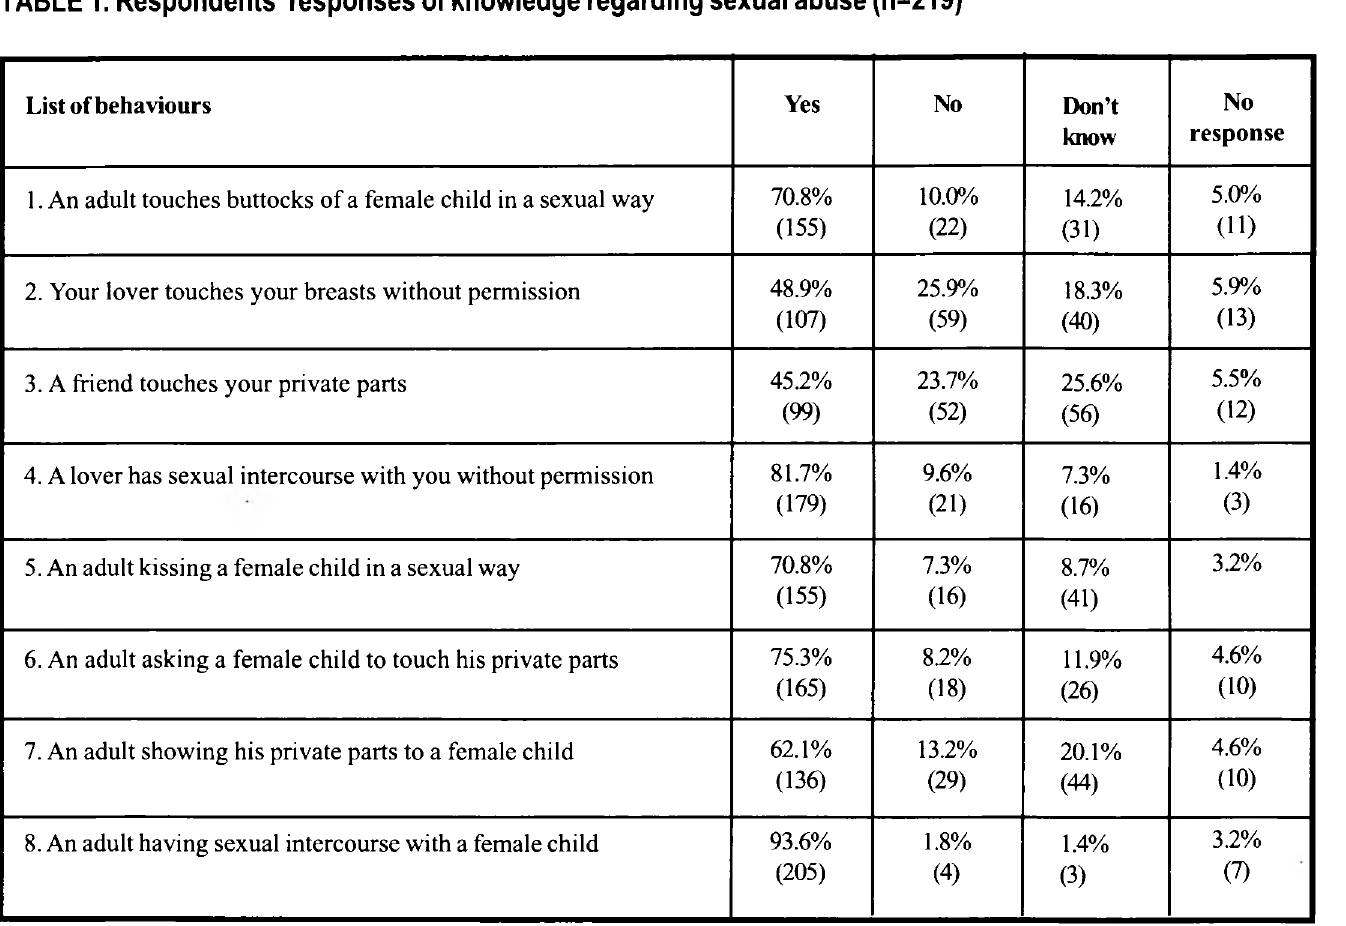
TABLE 1. Respondents’ responses of knowledge regarding sexual abuse (n=219)